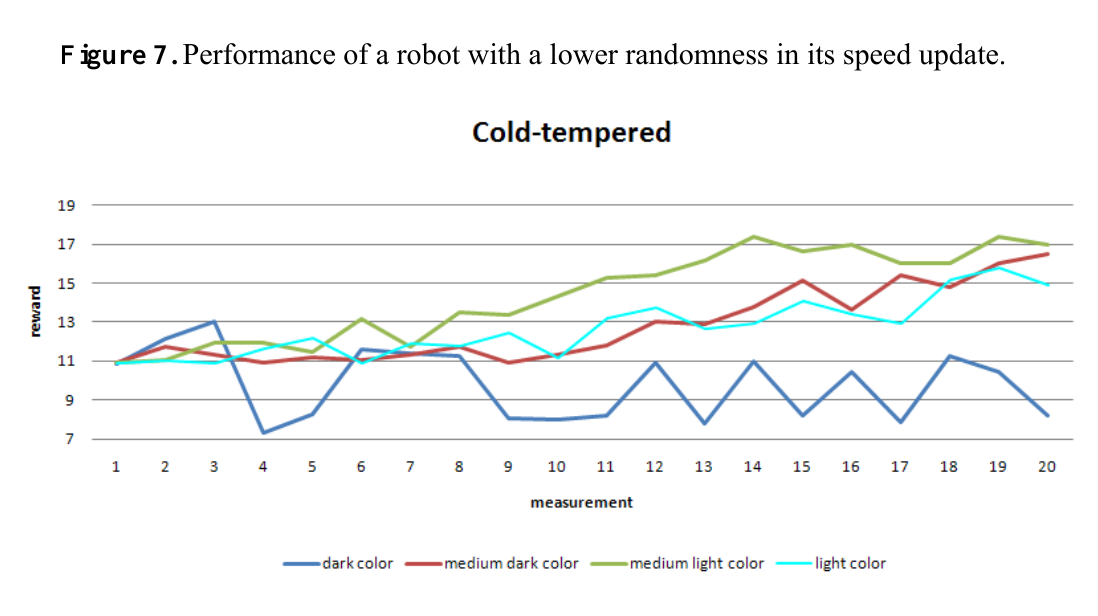
Figure 7. Performance of a robot with a lower randomness in its speed